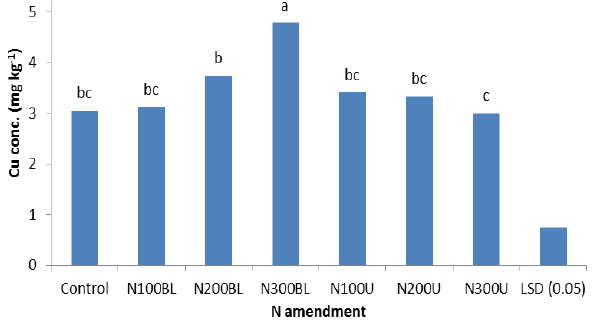
Fig. 4. The effects of N source and rate on Zn concentration of silage corn. Means with the different letters show significant difference (LSD, P ≤ 0.05). See Fig. 2 for abbreviations